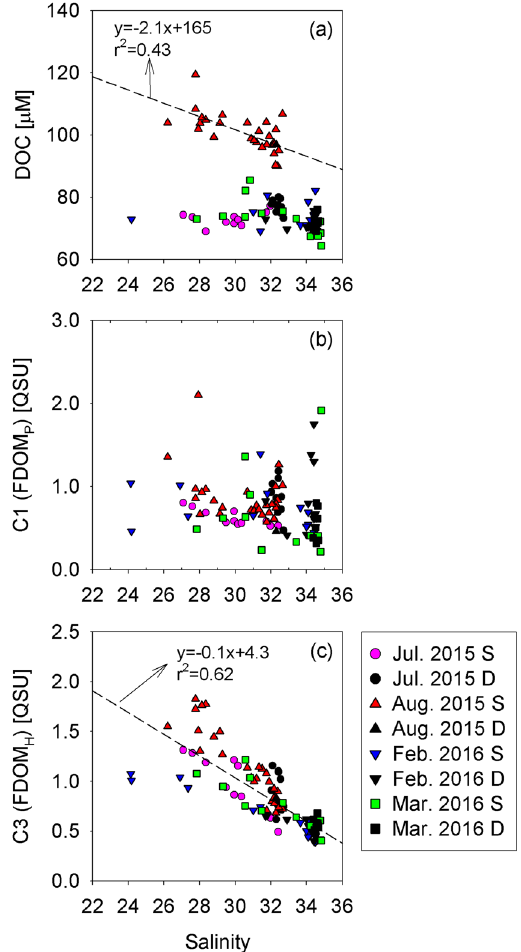
Figure 4. Scatterplots of the concentrations of ( a ) DOC, ( b ) FDOM P and ( c ) FDOM H against salinity in Jochun Bay. S and D represent the samples in surface and deep waters,